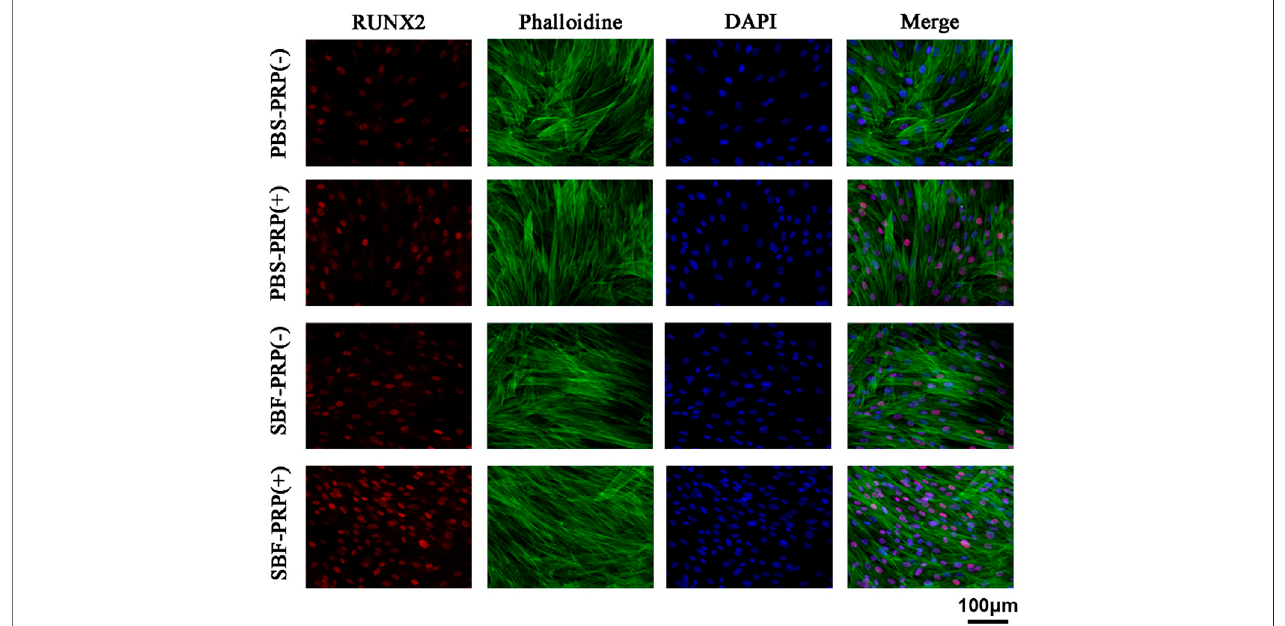
FIGURE 6 | RUNX2 expression of BMSCs cultivated on PBS-PRP (-), PBS-PRP (+), SBF-PRP (-) and SBF-PRP (+) hydrogels. RUNX2, F-actin and nuclear were visualized by RUNX2-speci fi c antibodies (red), rhodamine phalloidin (green) and DAPI (blue) respectively.